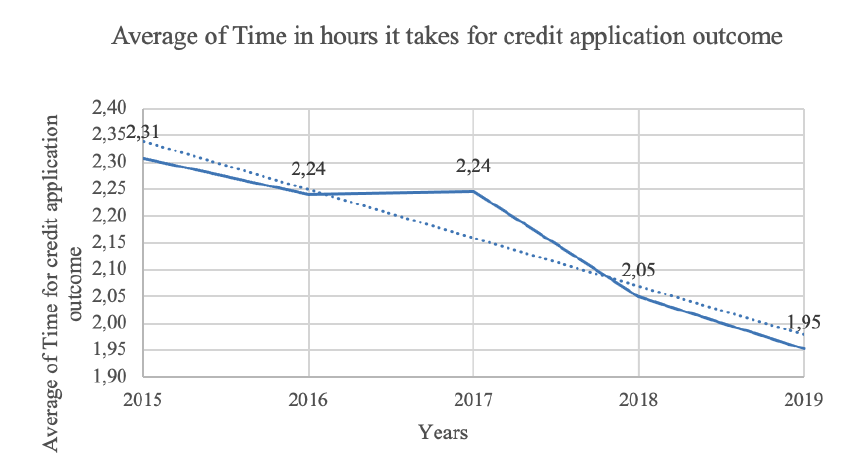
Figure 1: Trend analysis for Time it takes for credit application outcome; Source: Survey data (2021)